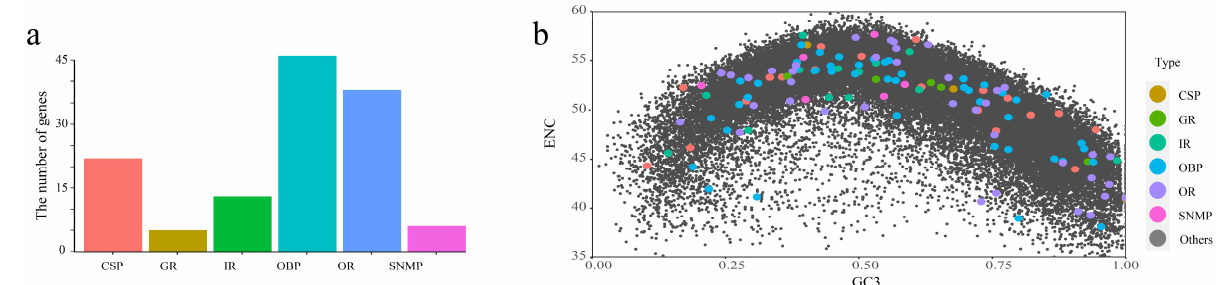
Figure 3. Codon usage bias of chemosensory genes in T. meditationis . ( a ) Number of identified chemosensory genes. Odorant-binding protein (OBP), chemosensory protein (CSP), odorant receptor (OR), ionotropic receptor (IR), sensory neuron membrane protein (SNMP), and gustatory receptor (GR). ( b ) The ENC-GC3 plot of chemosensory genes. Chemosensory genes are coloured according to ( a ). The gray points represent other